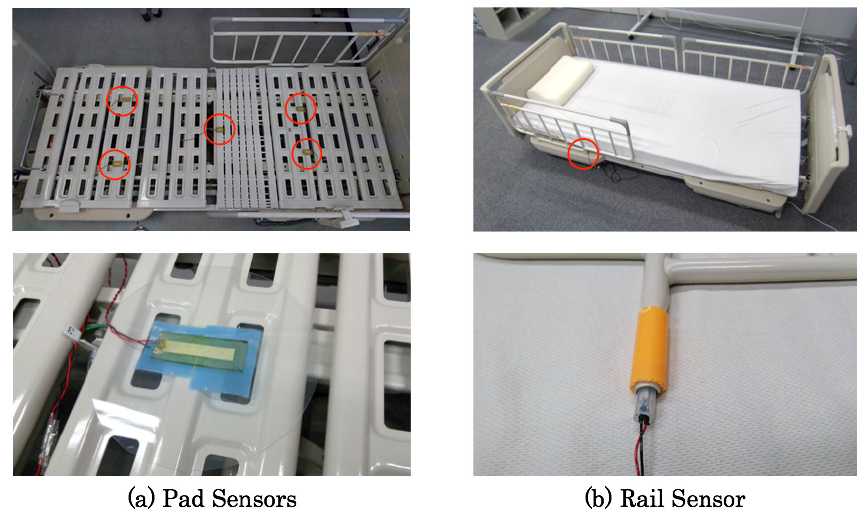
Figure 9. Sensor installation.